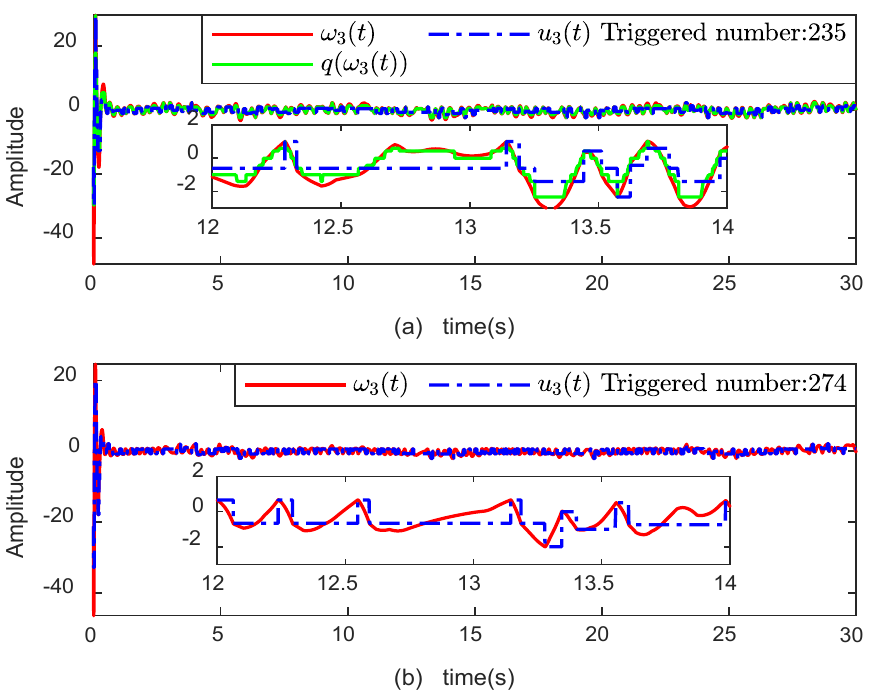
Figure 10. The trajectories of ω 3 , q ( ω 3 ) , and u 3 . ( a ) with quantized control. ( b ) without quantized